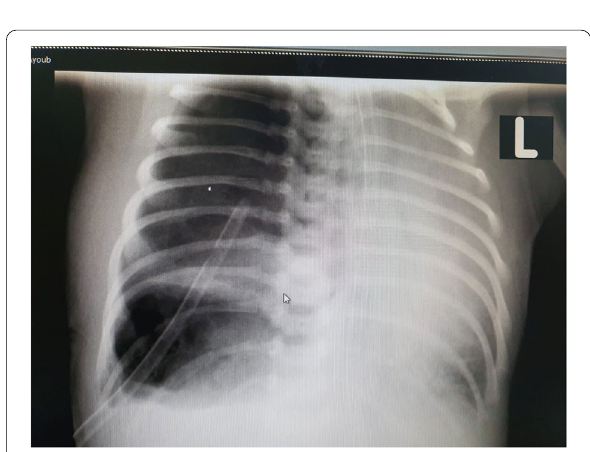
Fig. 8 CXR with trapped pneumothorax and right chest tube in